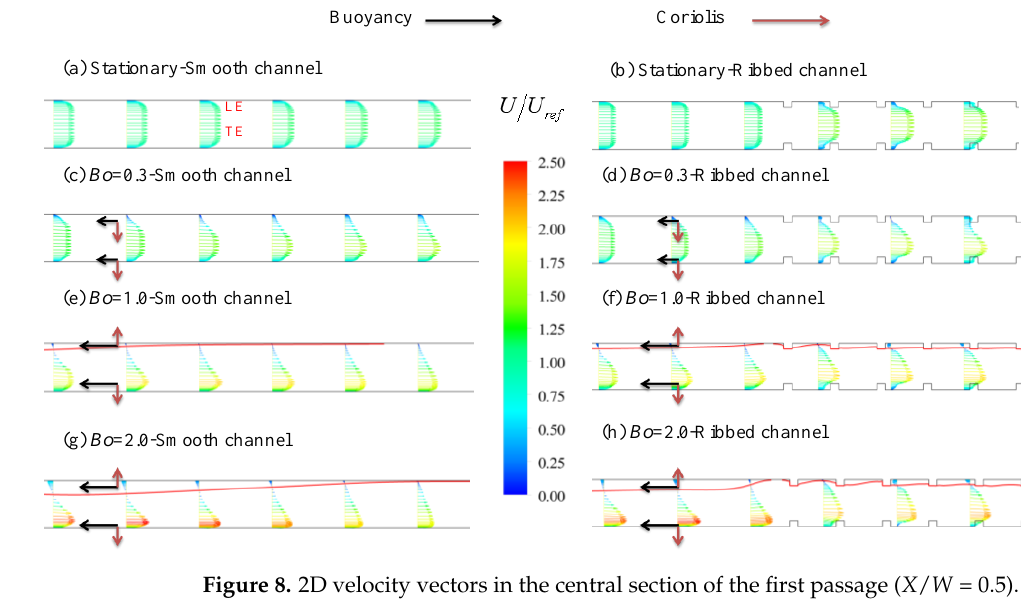
Figure 8. 2D velocity vectors in the central section of the first passage ( X / W = 0.5).